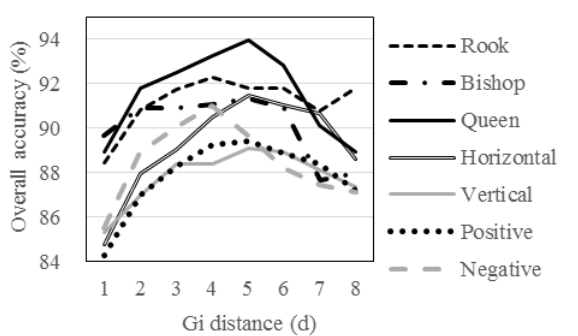
Figure 1. RF classification accuracies using the eight GLCM textural features across a range of window sizes